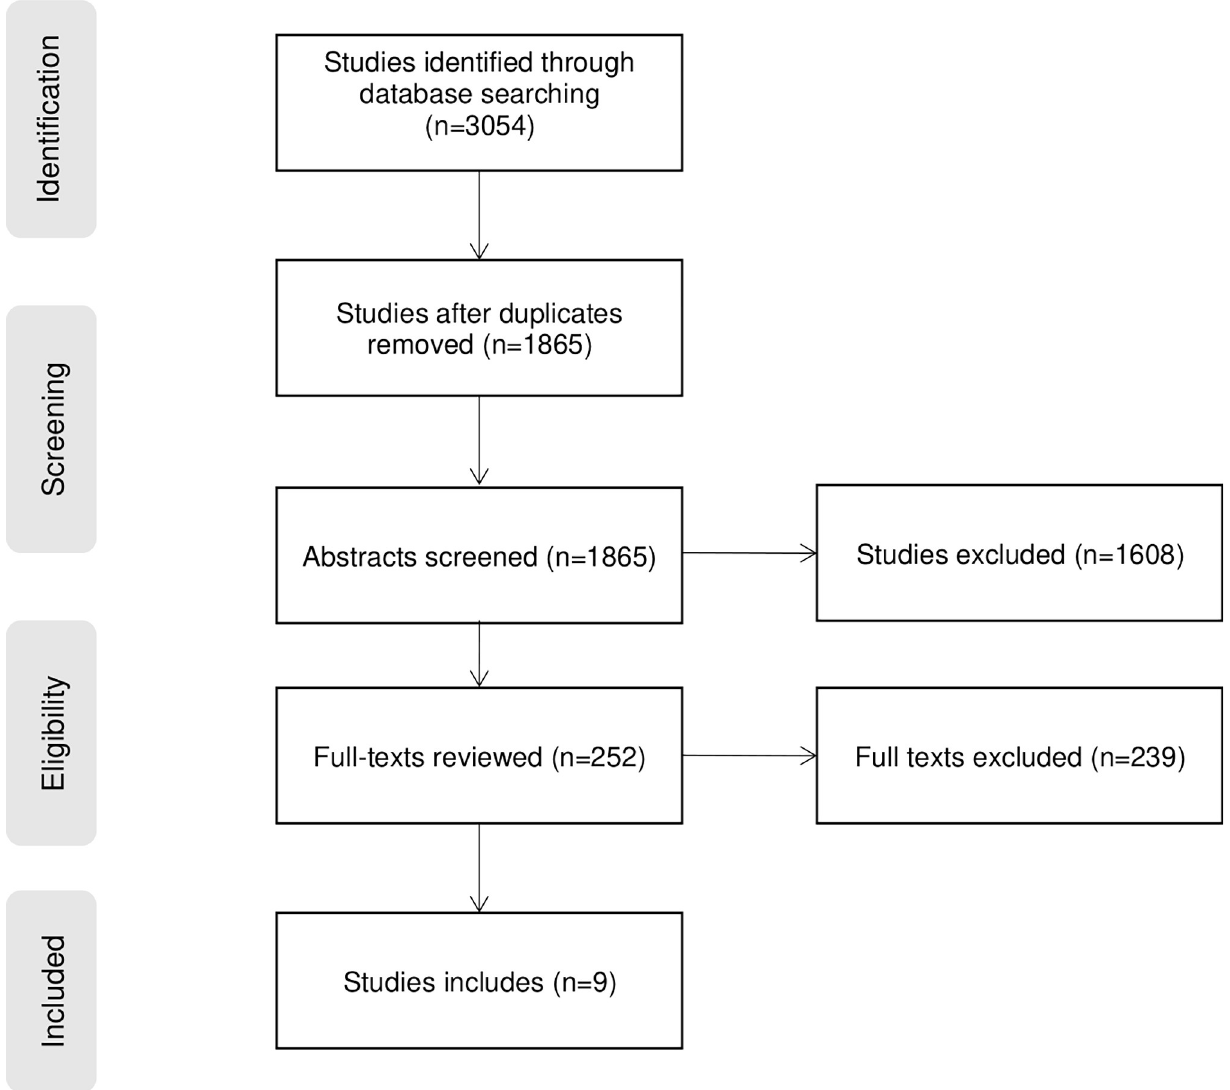
Fig 1. PRISMA diagram illustrating study selection